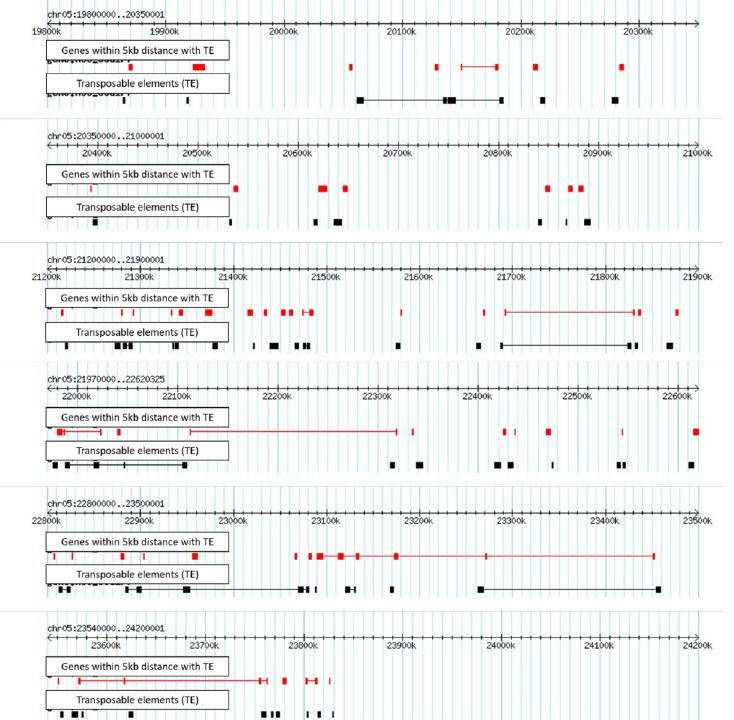
Fig. 2. Overview of TE distribution in qBFR4 (red box represent genes within 5kb distance with TE, black box represent TE, line between genes represent tandem repeats of the